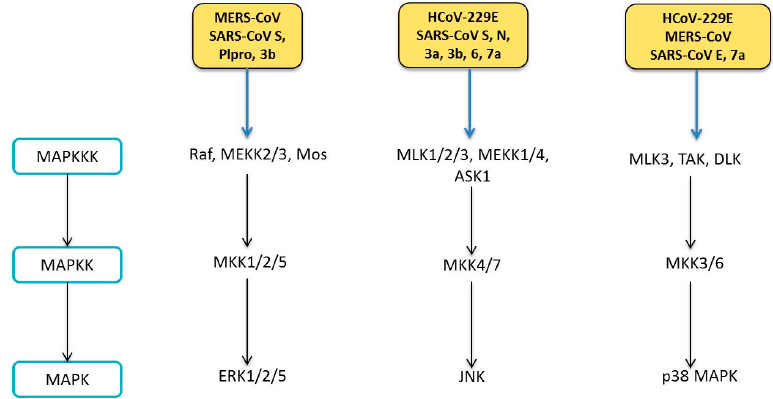
Figure 7. HCoVs on MAPK signalling pathways. MAPK pathways comprises of the ERK, JNK and p38 MAPK pathways. During HCoV infections, the signals are transduced by the MAPK pathways by a three-tier protein kinase cascade, with the kinase of each tier being phosphorylated by upstream kinases at the Thr and Tyr residues. HCoVs and their viral proteins (yellow-orange boxes) have been shown to induce these MAPK pathways as shown in the